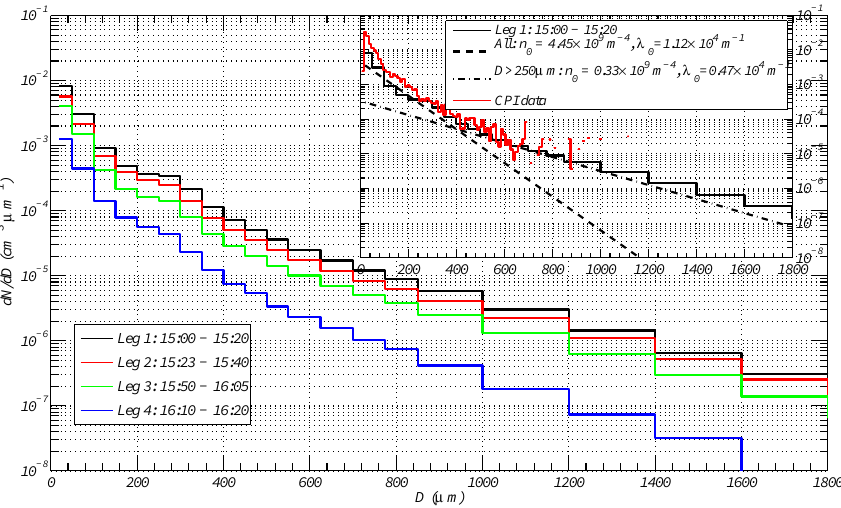
Fig. 7. Particle size distributions as determined with the CAPS-CIP for legs 1 to 4. Inset, CAPS-CIP size distribution for leg 1, showing exponential fits for all particles (black dashed-dot line) and also for particles with D ≥ 250µm (dashed black line). CPI size distributions are shown for comparison in red